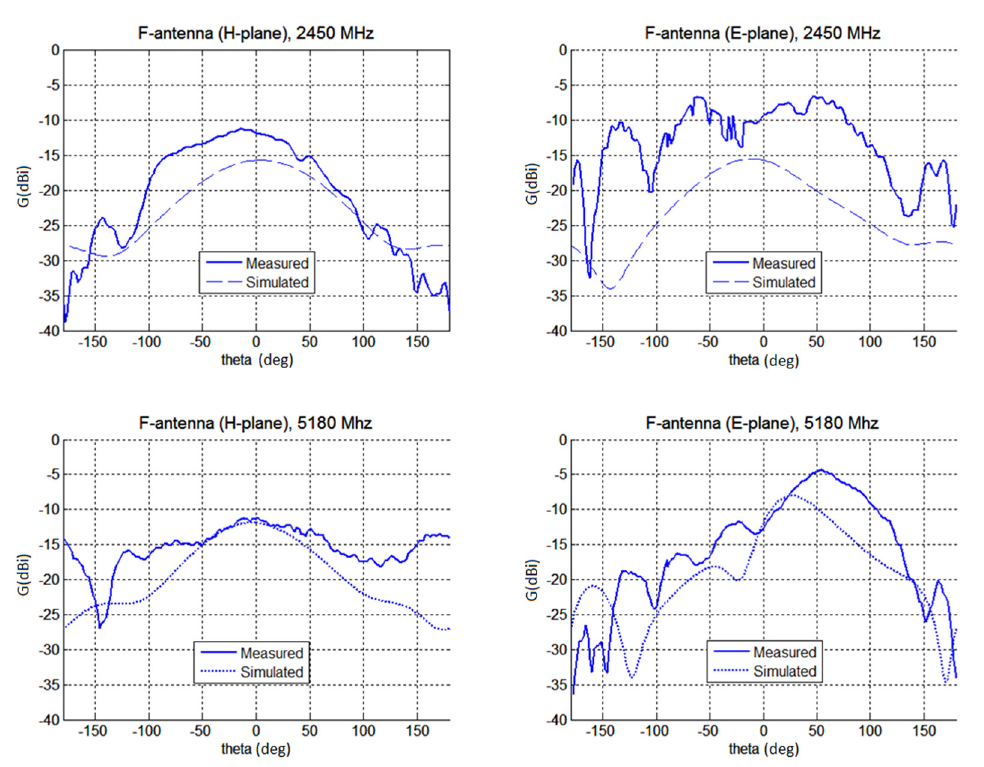
Figure 18. The measured and simulated gain of the F-antenna (top line, absolute gain for H and E-plane at 2450 MHz, bottom line, absolute gain for H and E-plane for 5180 MHz).